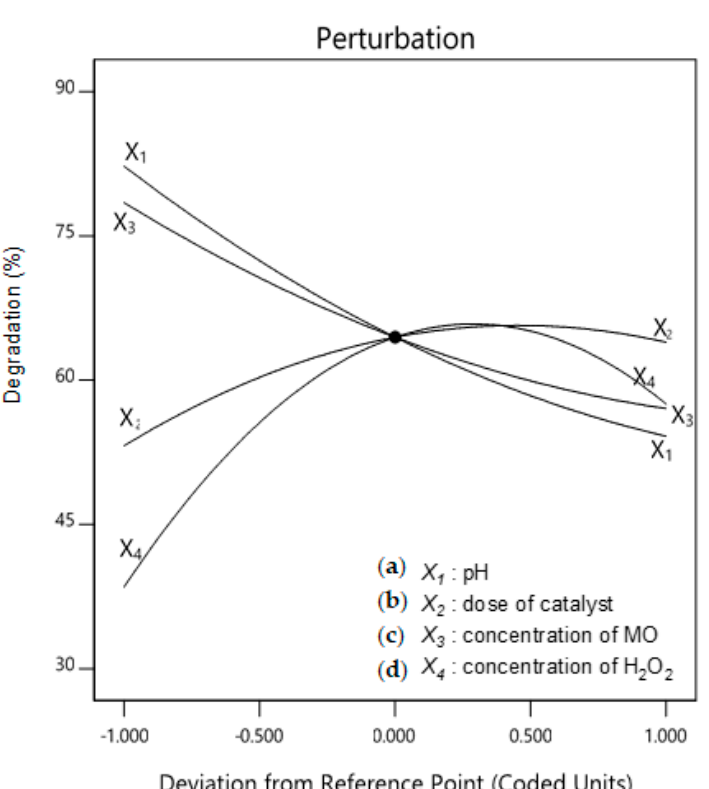
Figure 6. The variation of the deviation from the reference point for photocatalytic degradation using Gd 2 O 3 -ZIF-8 nanocomposites with ( a ) X 1 : pH, ( b ) X 2 : dose of catalyst, ( c ) X 3 : concentration of MO, and ( d ) X 4 : concentration of H 2 O 2 .